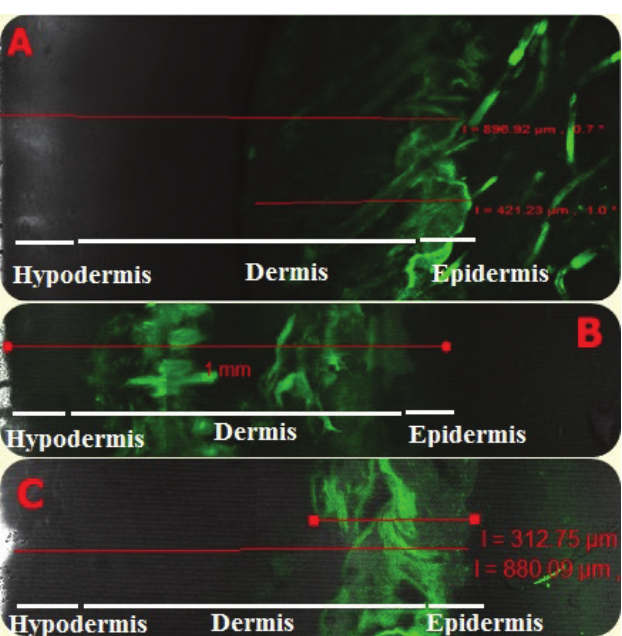
FIGURE 6 - Confocal microscope images of the penetration of A) A. squamosa extract-entrapped noisome; B) A. squamosa extract-entrapped liposome and C) Free Rhodamine across the different skin